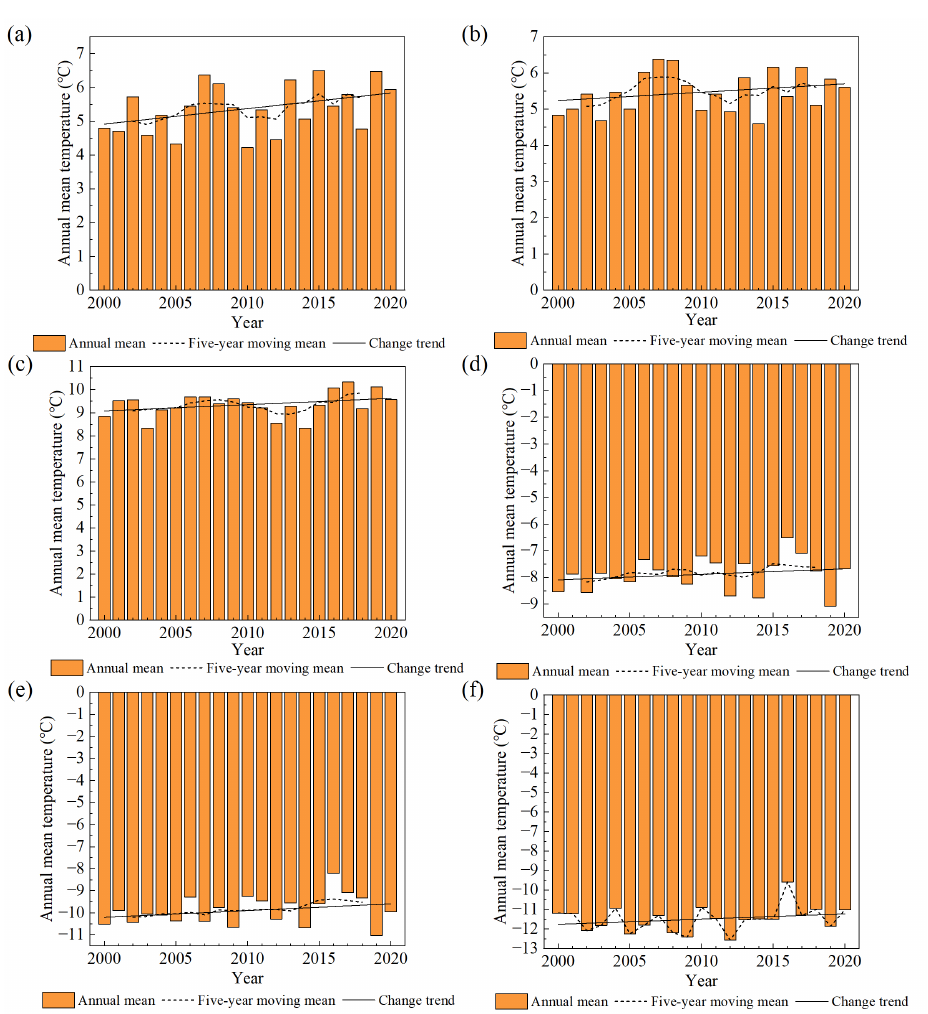
Figure 9. Temperature of six lakes in Xinjiang from 2000 to 2020 ( a ) Ulungur Lake; ( b ) Manas Lake; ( c ) Bosten Lake; ( d ) Ayakkum Lake; ( e ) Aqqikkol Lake; ( f ) Aksayquin